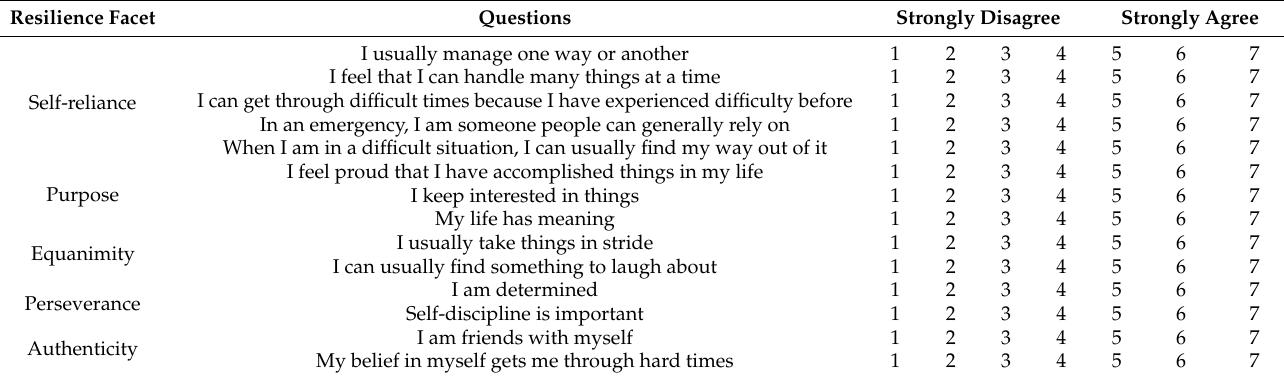
Table 1. Resilience scale (RS-14) and the resilience characteristics (facet) measured. Resilience